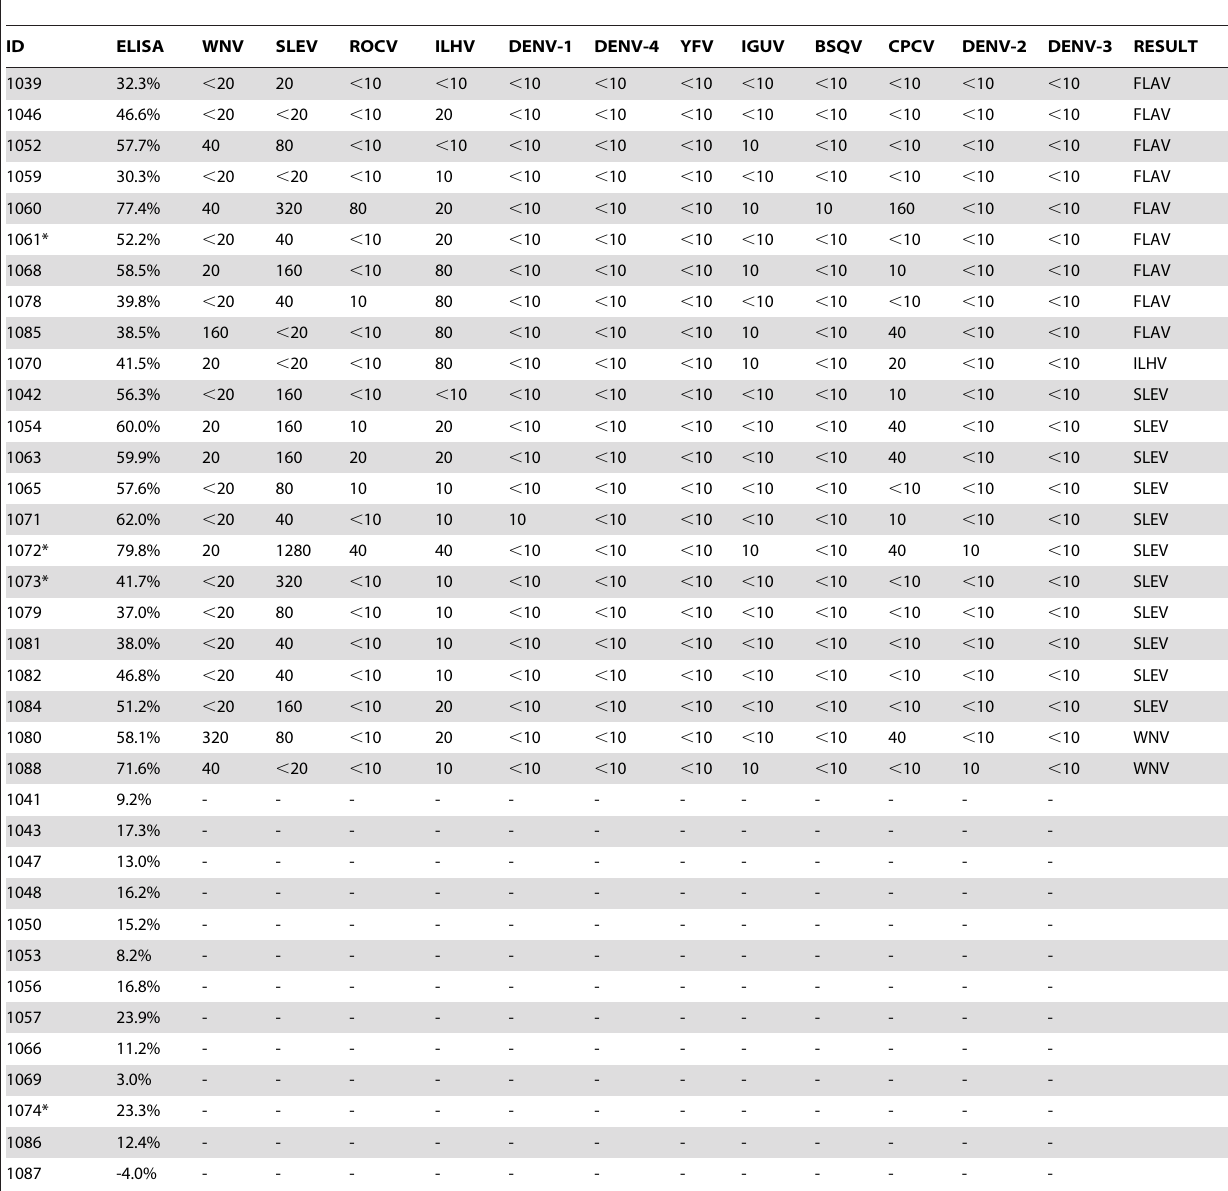
Table 4. Equines of a ranch, where an epizootic of undiagnosed neurological syndrome was reported in 2009 and 2010, located in the Nabileque Sub-region of the Pantanal,